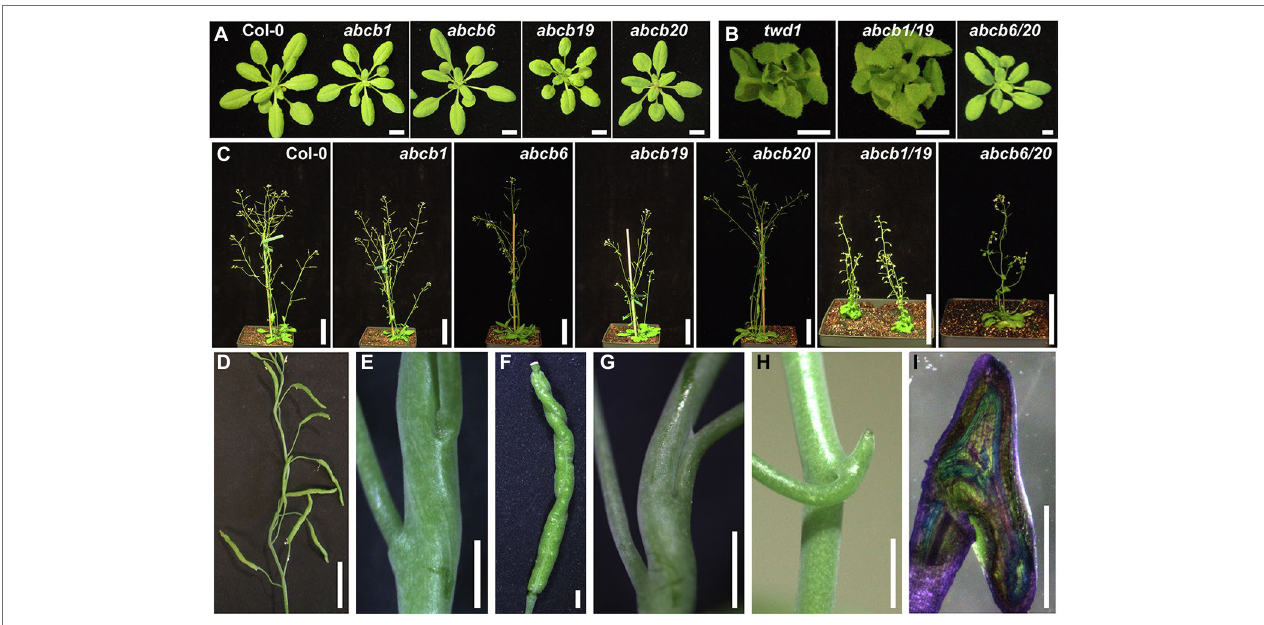
FIGURE 3 | Aerial tissue phenotypes observed in twd1 can be attributed to loss of ABCB1, 6, 19, and 20 function. (A) Single abcb mutant rosettes 21 days after germination. (B) twd1 and double abcb mutant rosettes 21 days after germination. (C) Mature single and double abcb mutants 35 days after germination. (D) Twisting of inflorescence stems in abc b6/20 double mutants. (E,F) Close-ups images of abcb6/20 showing (E) twisted cell files and (F) twisted siliques. (G) Occasional stem–pedicel separation defects observed in abcb6/20 mutants. (H) Cantil spur formation in abcb1/19 grown under 50 μ mol m − 2 s − 1 , 16-h photoperiod. (I) Toluidine blue O staining of hand sectioned abcb1/19 cantil spur from (H) . Scale bars: (A) 1 cm; (B,I) 0.5 cm; (C) 5 cm; (D,H) 1 cm; (E–G) 1